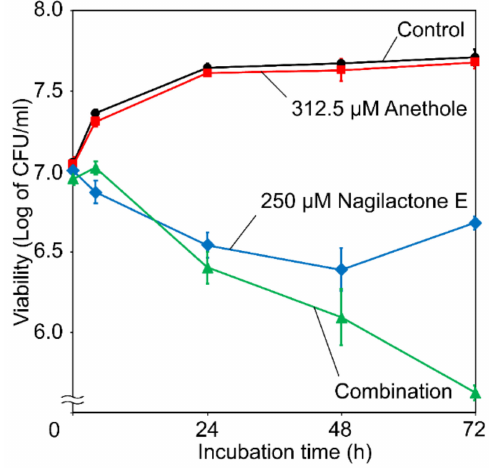
Figure 2. Cell viability in the presence of anethole, nagilactone E, or their combination. Exponentially growing cells of S. cerevisiae BY 4741 at 30 °C in YPD medium supplemented with 312.5 µM anethole ( ■ ), 250 µM nagilactone E ( ◆ ), or 312.5 µM anethole + 250 µM nagilactone E ( ▲ ). Closed circles ( ● ) denote controls (treatment without drugs). Data are expressed as the mean ± standard deviation (n =